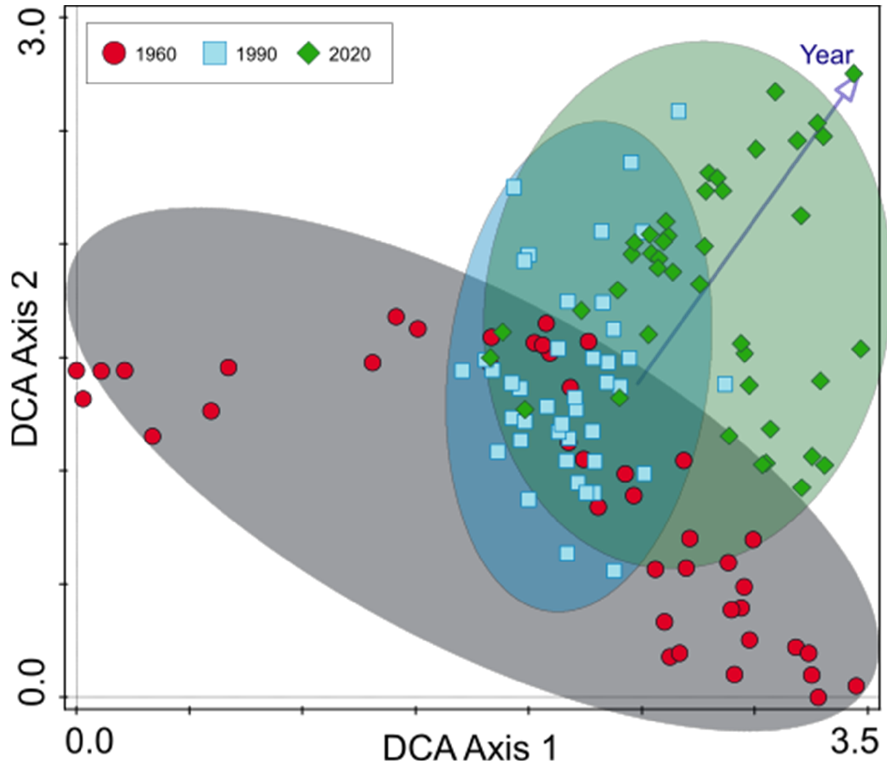
Figure 3. DCA ordination diagram for the 126 vegetation plots of the protected, ancient riparian forests in the area of the Odra Valley near Oława (Silesian Lowland, Southwestern Poland), surveyed in 1960, and resurveyed in 1990 and 2020. The gradient length is 3.47 SD. The diagram shows the herbaceous vegetation pattern within plots during the last 60 years. The vector of Year variable was passively projected into a diagram.